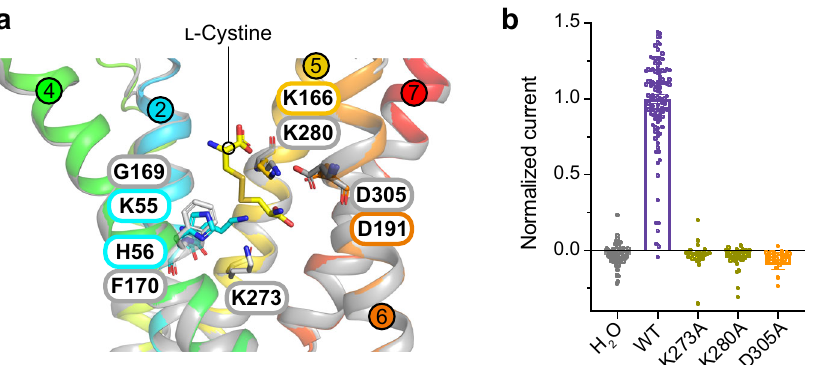
Fig. 3 | Differences in the binding site between plant and human cystinosin. a Structural superimposition of the plant crystal structure (coloured helices and numbers) and human AlphaFold2 model (grey) revealing the movement of key residueswithinthebindingsite. b TEVCdatashowingtheeffectofmutationswithin